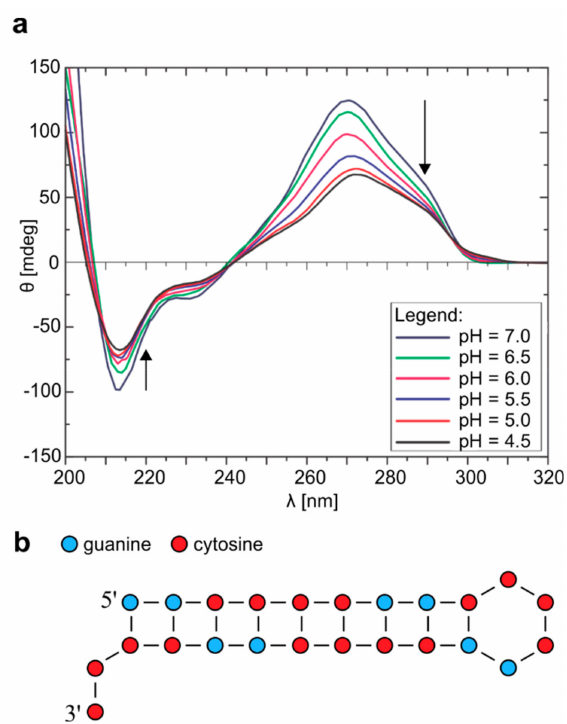
Figure 2. CD spectra of r(G 2 C 4 ) 4 and proposed hairpin adopted at pH 4.5. ( a ) CD spectra of r(G 2 C 4 ) 4 with pH ranging from 7.0 to 4.5. All CD spectra were acquired at 25 ◦ C and concentration of 100 µ M per strand. Arrows represent the direction of change in pH. ( b ) Schematic presentation of hairpin formed by r(G 2 C 4 ) 4 at pH 4.5 and 25 ◦